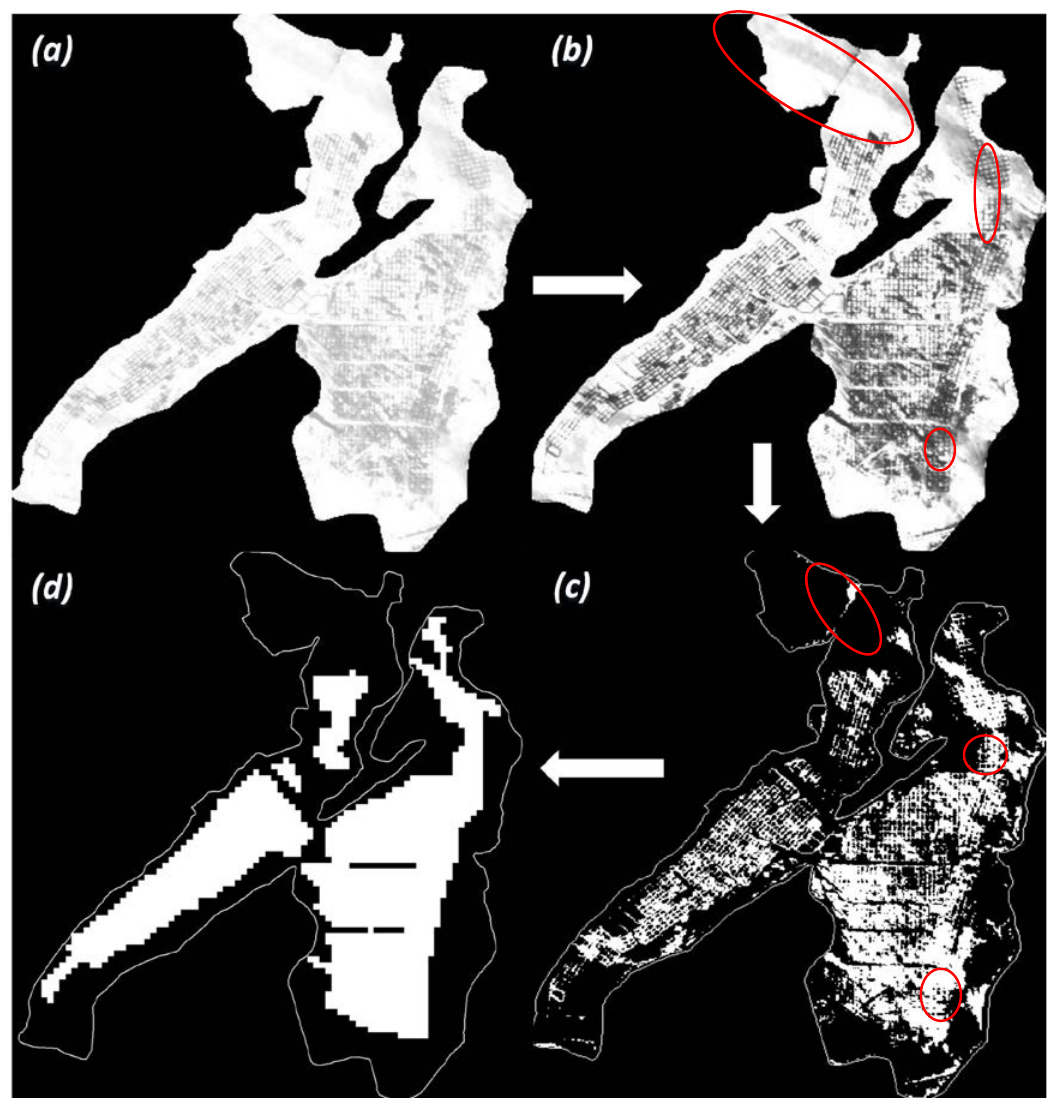
Figure 3. NIR band image ( a ), enhanced image ( b ) derived from Equations (1) and (2), segmented image based on Equation (3) ( c ) and extracted resultant map of pen aquaculture based on Equation (6) ( d ). The white areas within the red circles are noise (e.g., aquatic vegetation and light cloud).